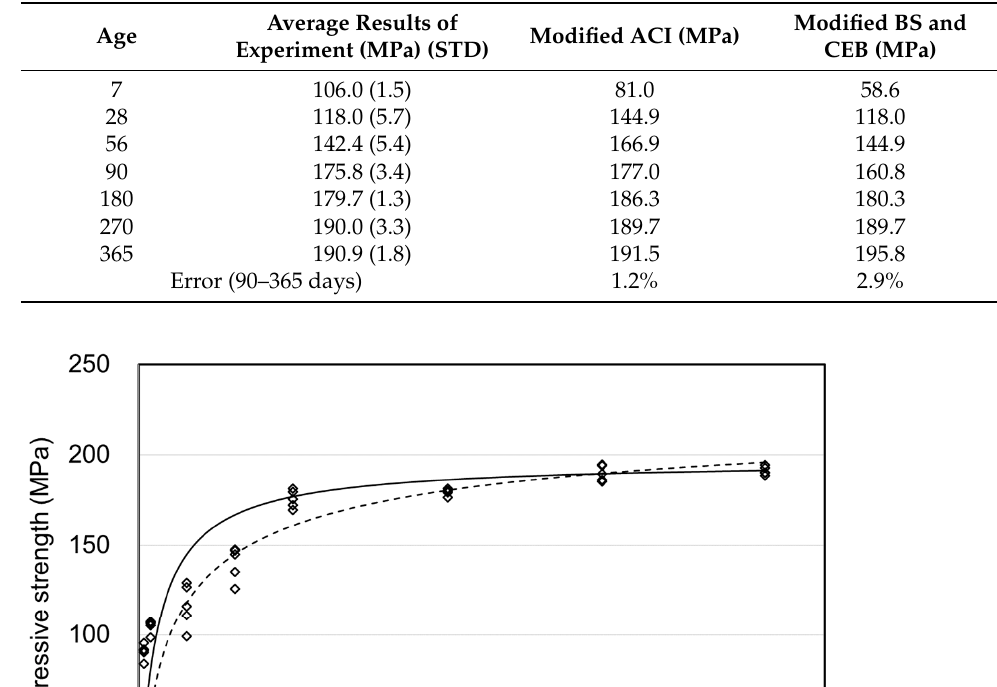
Table 4. Experiment results in moist curing compared with modified prediction models.